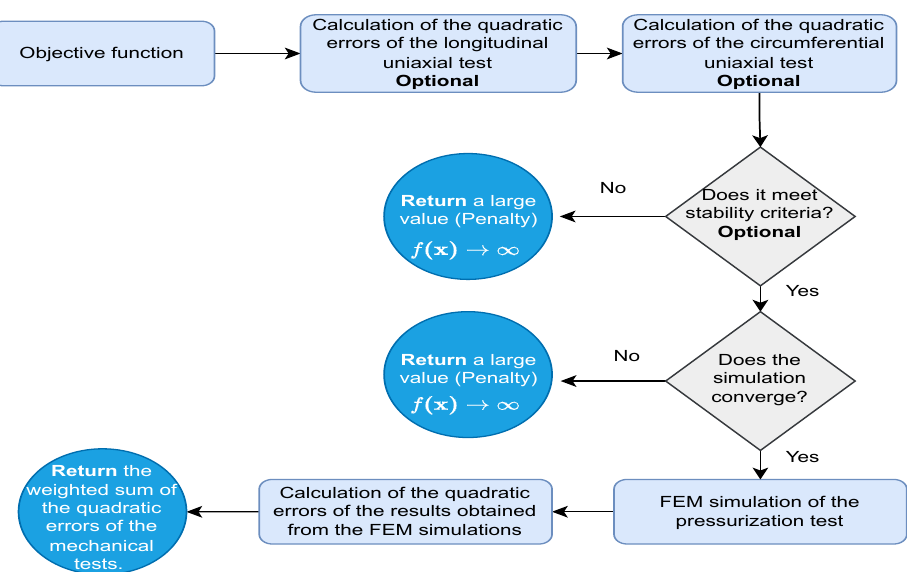
Figure 7. Block diagram illustrating how the objective function is